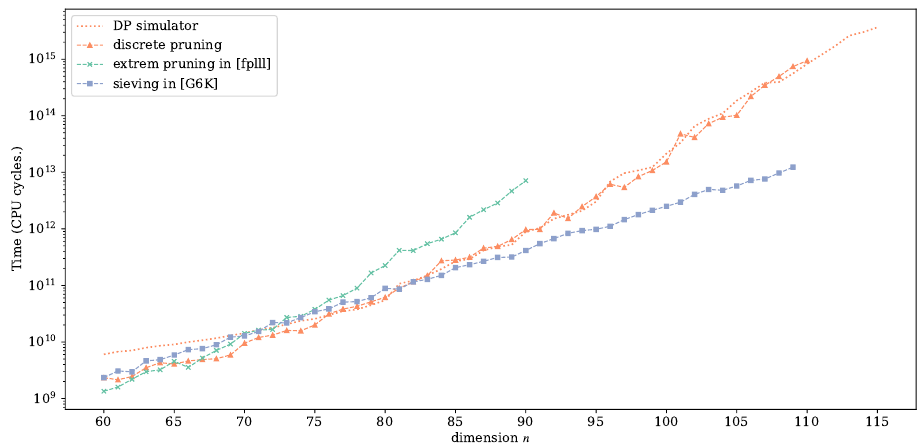
Figure 10. The performance of optimized discrete pruning and other SVP